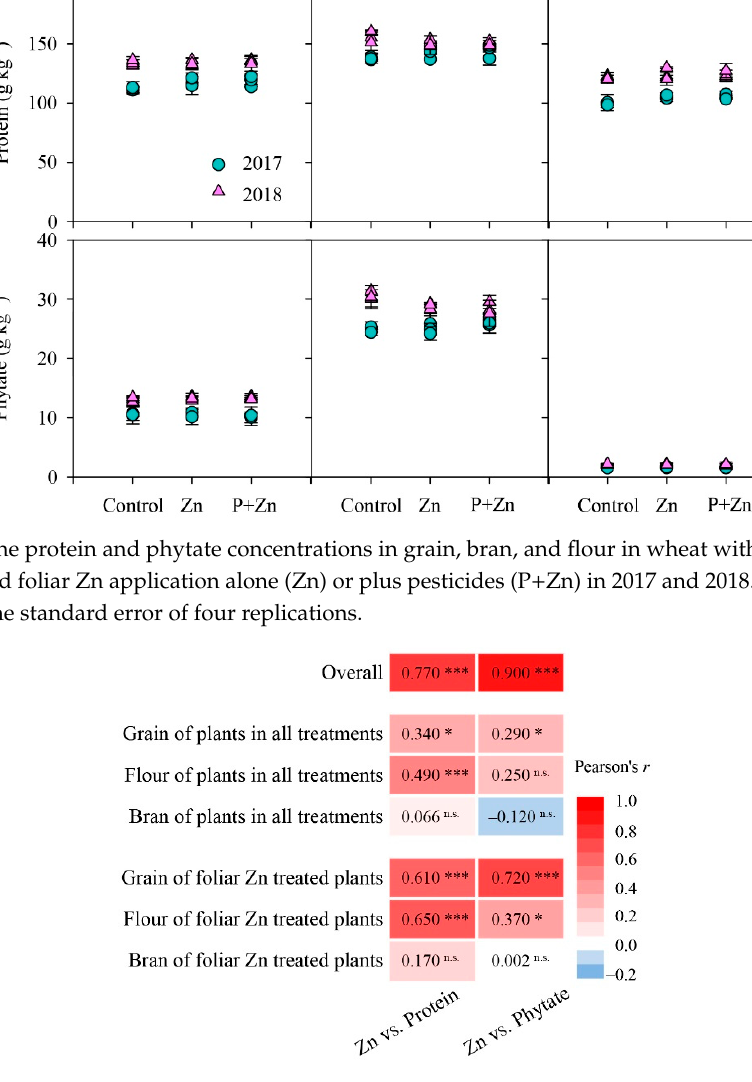
Figure 6. Pearson correlation coefficients between Zn and protein concentrations and between Zn and phytate concentrations in grain, bran, and flour of wheat plants from all treatments (control, foliar Zn, and Zn plus pesticides) or from foliar Zn spray treated plants (with and without pesticides). *, p < 0.05; ***, p < 0.001; n.s., not significant.